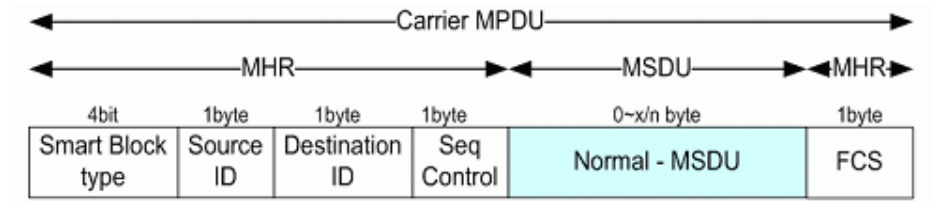
Figure 6. Normal Data Frame format.